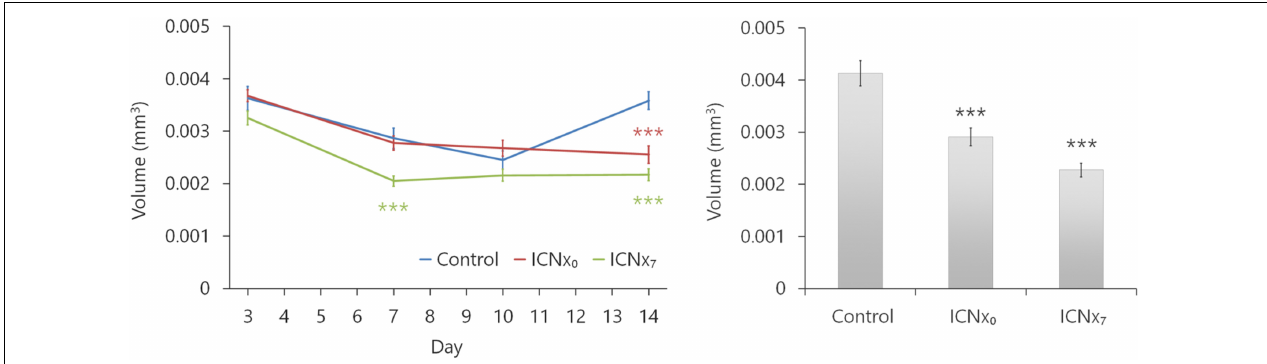
FIGURE 5 | ICN transection leads to smaller laser-induced CNV lesions. Lesion volumes were measured with SD-OCT at 3, 7, 10, and 14 days after laser treatment (left). Following euthanasia on day 14, volumes were measured ex vivo with confocal microscopy (right). By day 14, animals that underwent ICN transection had statistically smaller lesions than the animals that received sham surgery ( n ≥ 44 lesions per group from six animals per group; *** P < 0.001). This was true regardless of whether ICN transection was performed immediately after or 7 days after laser therapy. Error bars represent SEM.